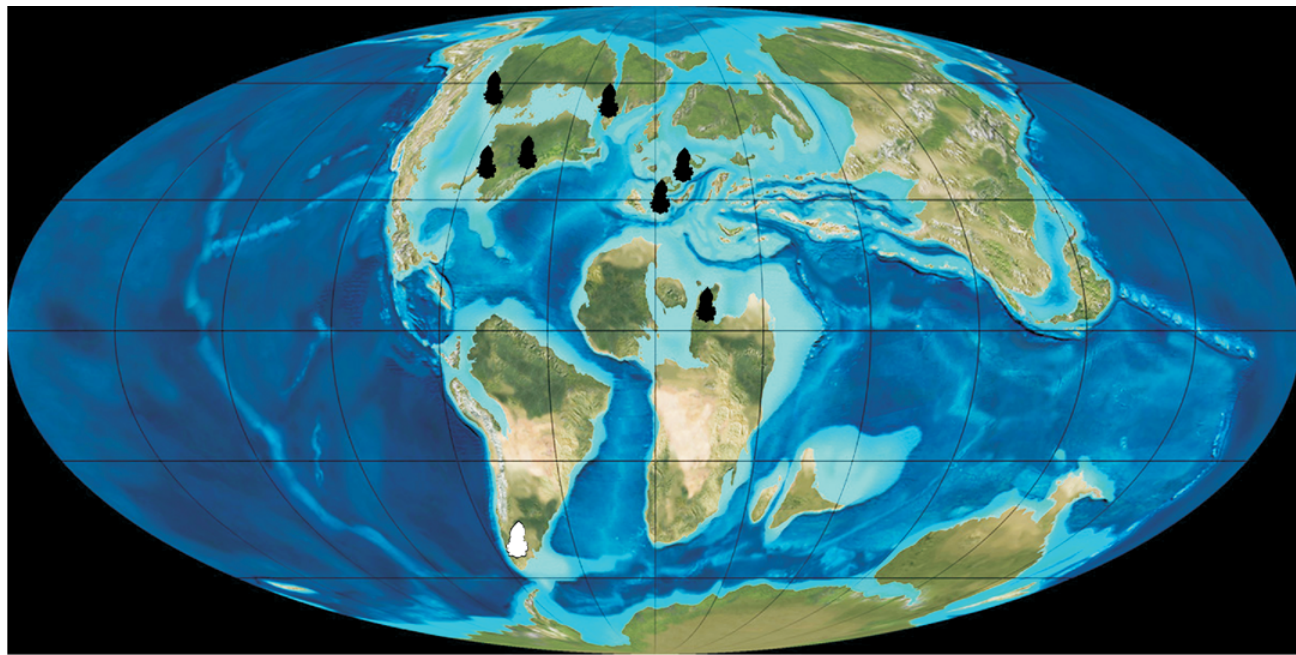
Fig. 5. Paleogeographic map of the Late Cretaceous (modified from Blakey 2010) showing the known distribution of Arcellites disciformis (black sym- bols), and the new Patagonian record (white